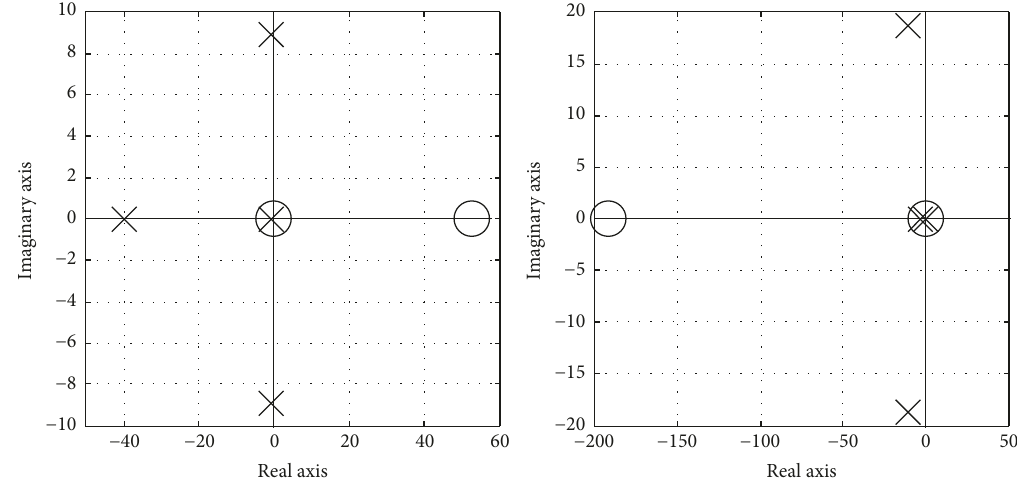
Figure 11: Robust H ∞ nonfragile control for vehicle body side-rolling acceleration. (a) Without perturbation. (b) With perturbation.